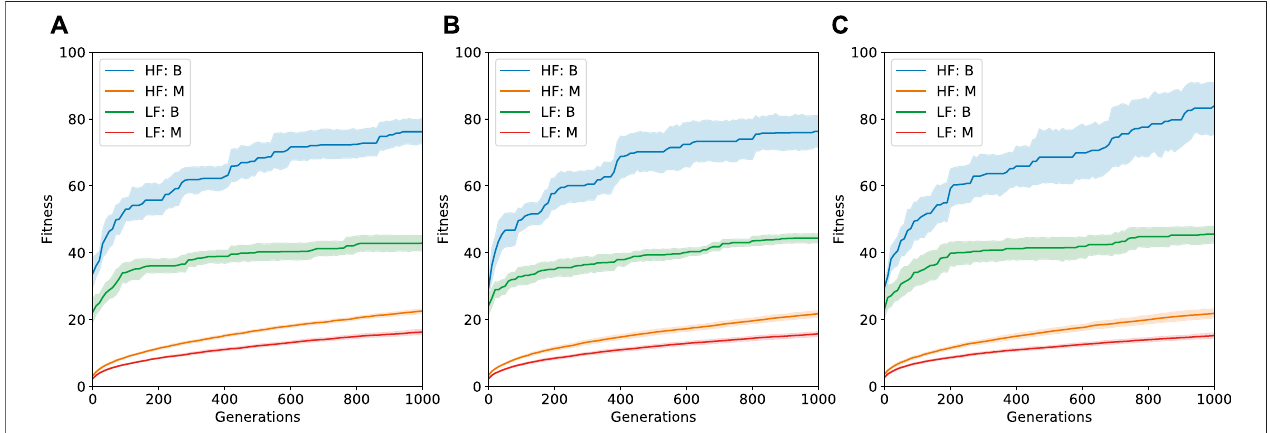
FIGURE 6 | Performance across 10 runs at the robot layer with varying levels of computational budget at the components layer (A: 20 Generations, B: 100 Generations, C: 1,000 Generations). The plots show median and best performance across the two environments with 95% con fi dence interval. HF (cid:2) High Friction Environment, LF (cid:2) Low Friction Environment, B (cid:2) Best, M (cid:2) Median. Fitness is the distance covered in the x -direction.